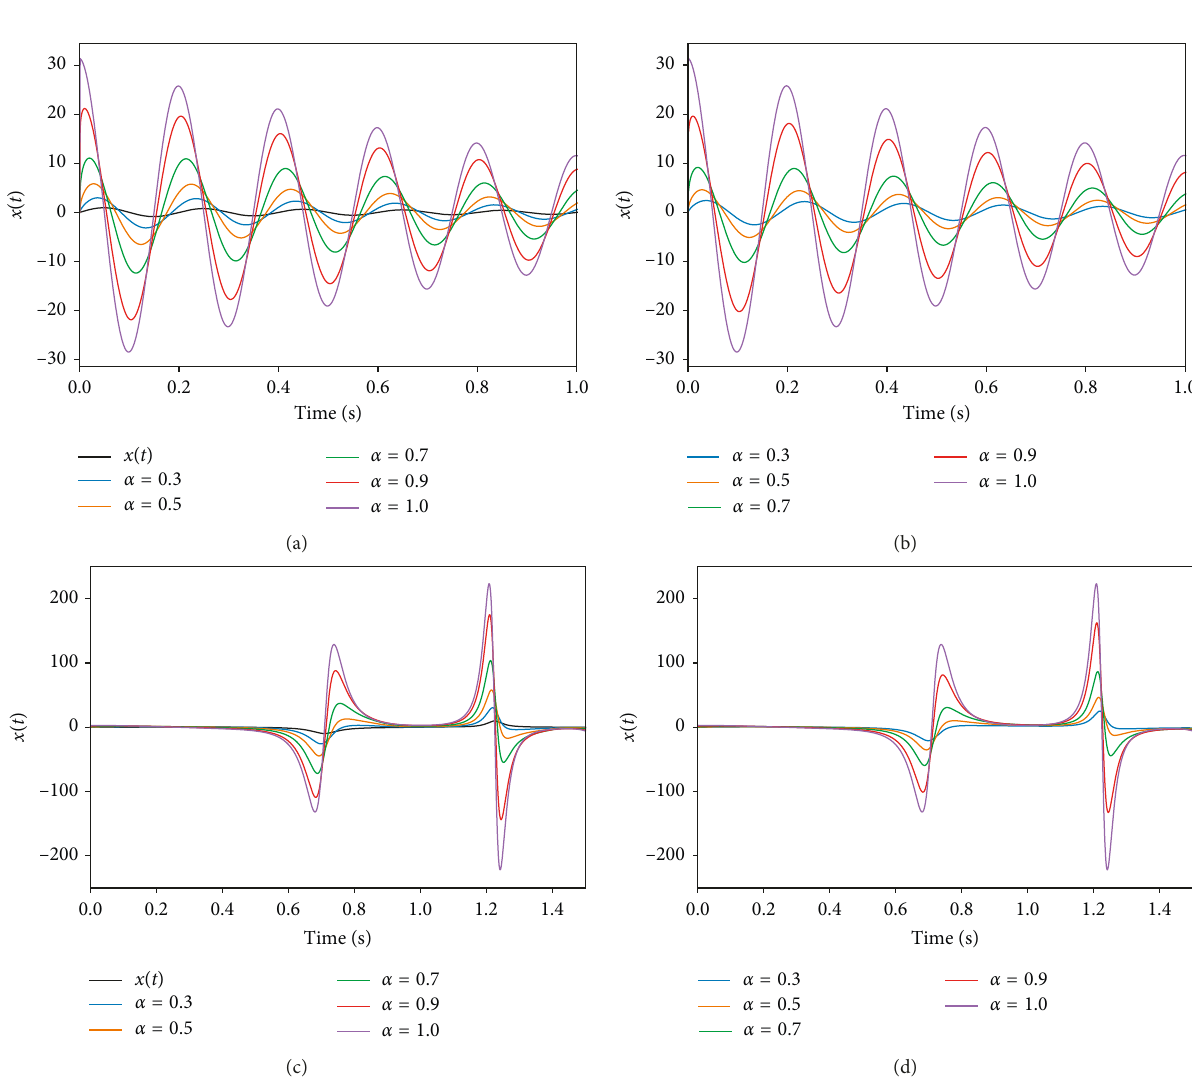
Figure 2: Fractional derivatives for the underdamped harmonic oscillator using (a) Gr¨unwald–Letnikov and (b) Riemann–Liouville (b) approaches. And fractional derivatives for the “sine-cosine function” using (c) Gr¨unwald–Letnikov and (d) Riemann–Liouville